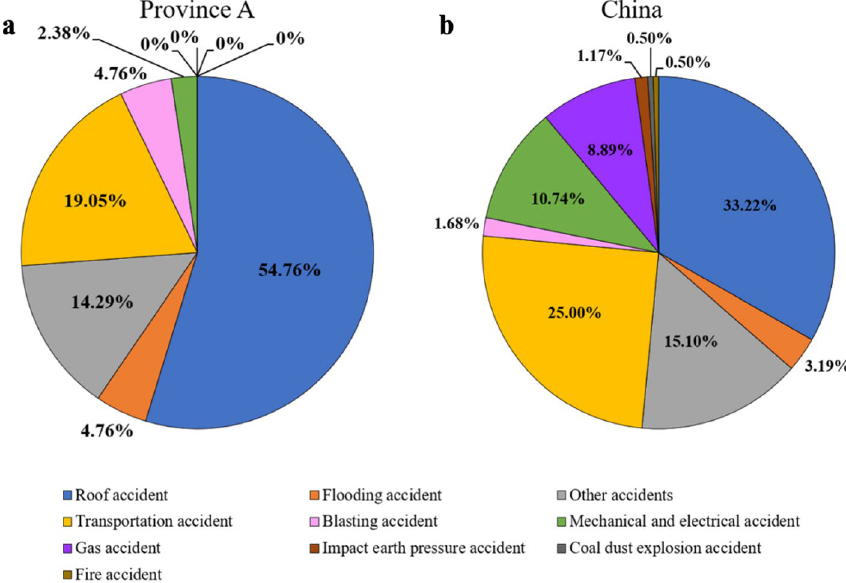
Figure 1. Comparison of the number of types of accidents in coal mines between China and Province A (2016–2020).